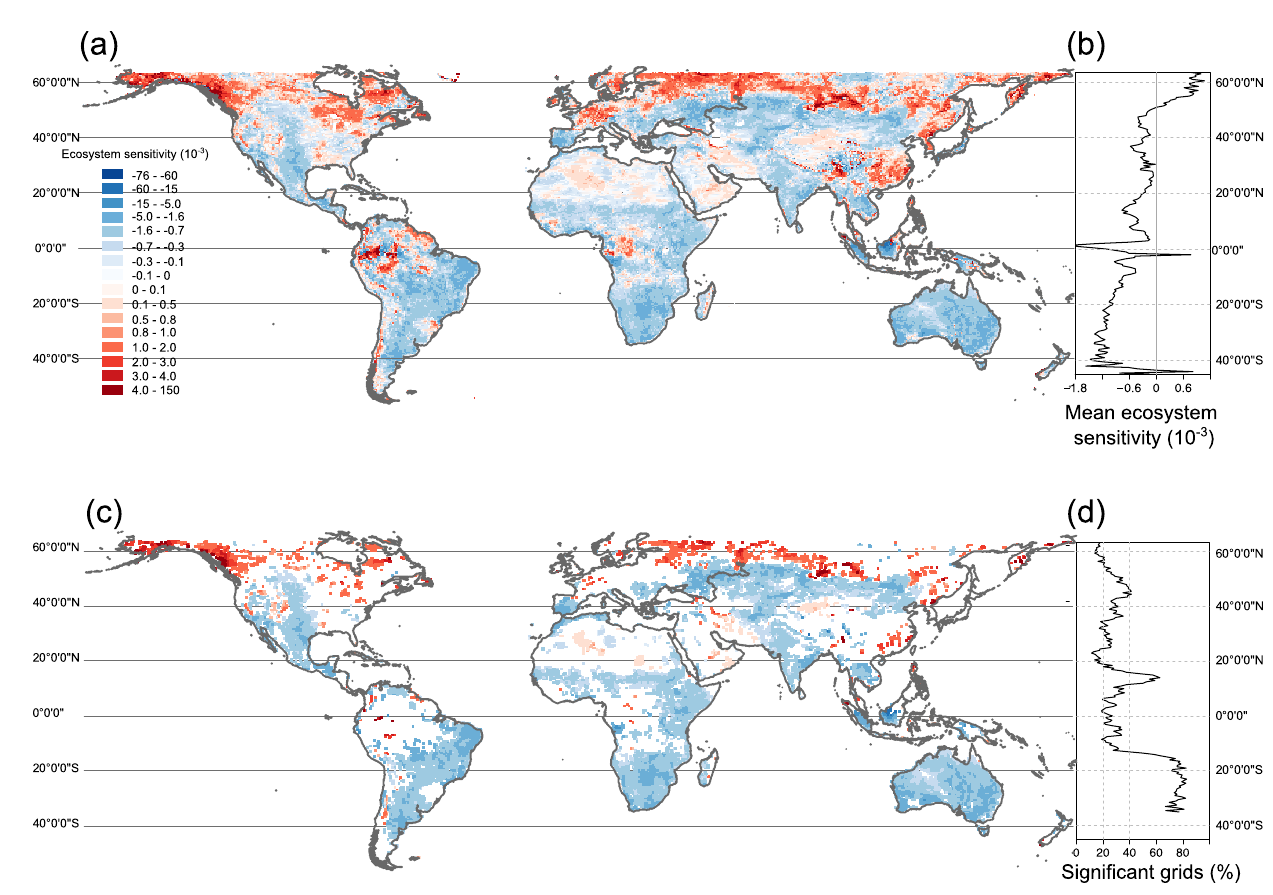
Fig. 3 Sensitivity of ecosystem productivity to variability in climatic water de fi cit (CWD) between 1982 and 2013 globally. a Shows calculated sensitivity values for the global terrestrial surface; c shows sensitivity values in locations where ecosystem sensitivity values are statistically signi fi cant (95% credible interval does not contain zero). b shows the mean ecosystem sensitivity by latitude and d shows the proportion of grid cells at each latitude where sensitivity values are statistically signi fi cant. Positive sensitivity (shades of red) implies increased ecosystem productivity in response to higher CWD, while negative values (shades of blue) suggest diminished productivity with higher CWD (i.e., drying, warming, or both).